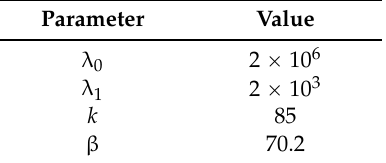
Table 2. The controller parameters.